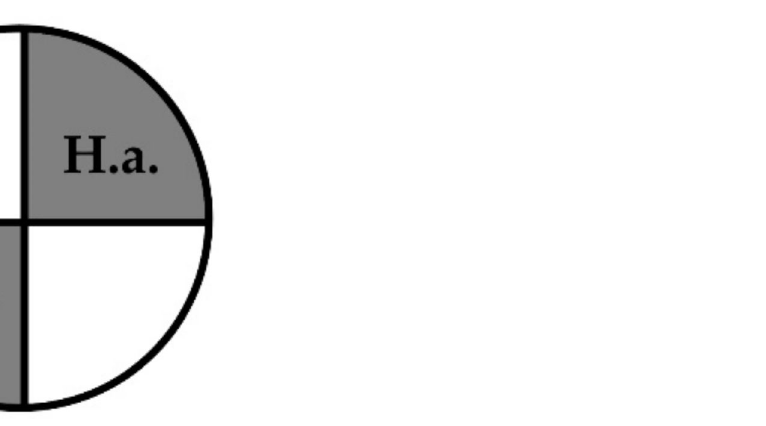
Figure 1. Spraying scheme of wood discs. Abbreviations: H.a.—area treated with Heterobasidion annosum conidial suspension; H.p.—area treated with H. parviporum conidial